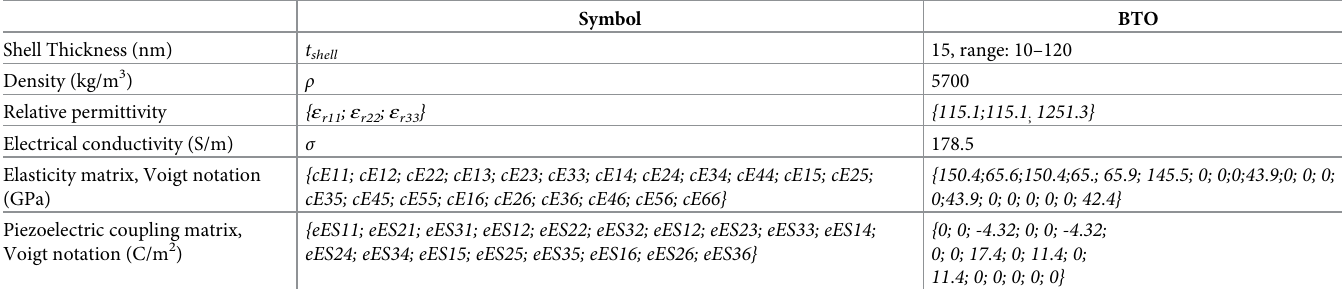
Table 2. Shell properties (from COMSOL library [35]).